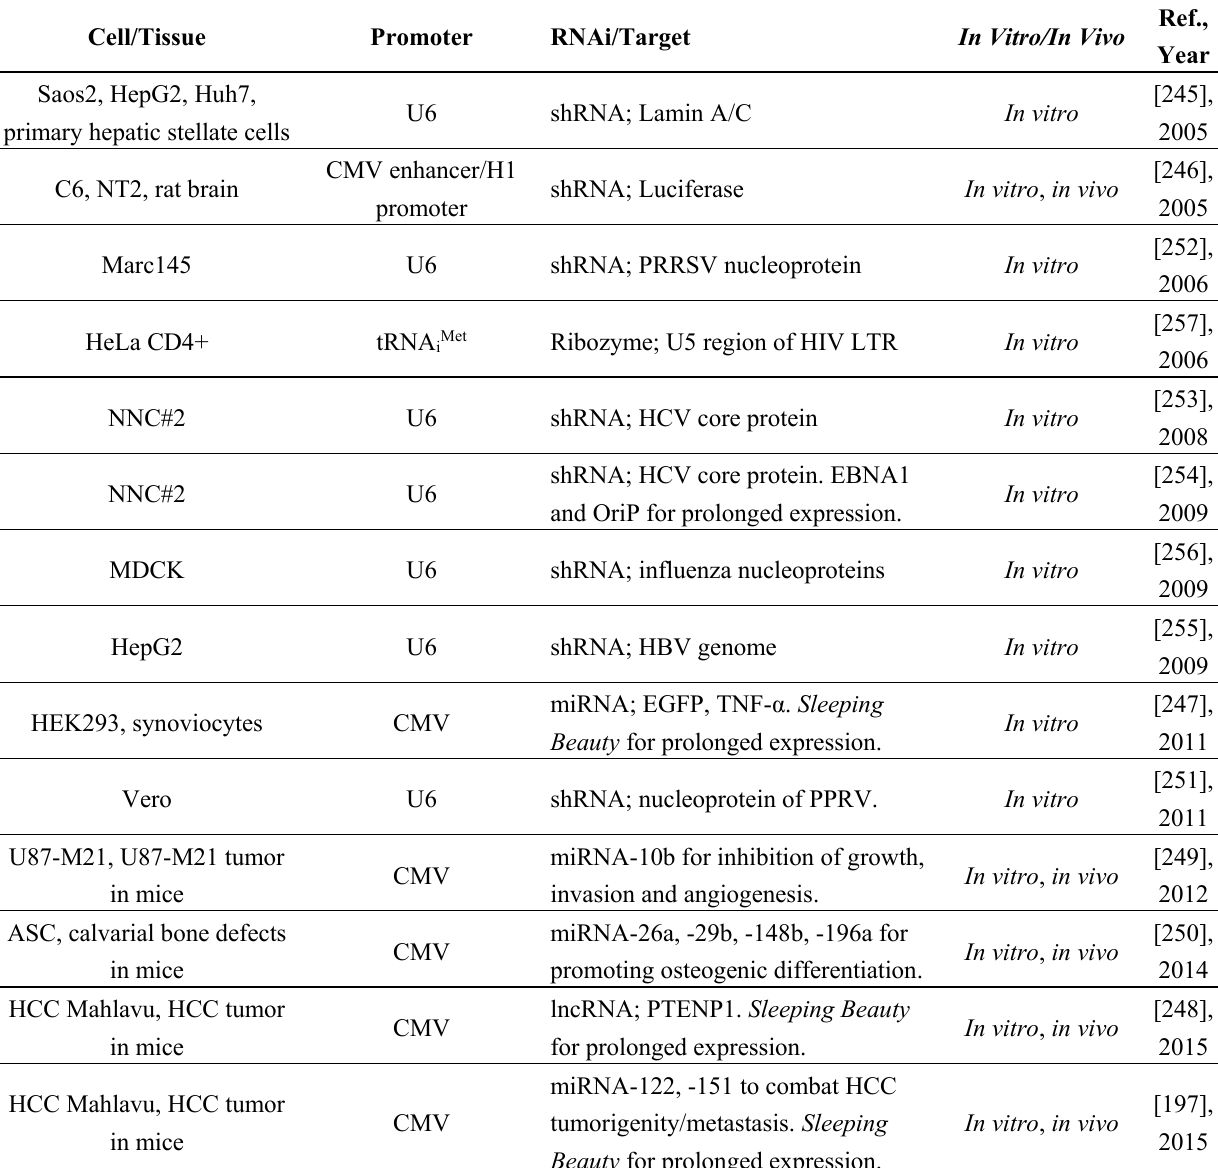
Table 1. Summary of baculovirus mediated preclinical RNAi studies in vertebrate cells.